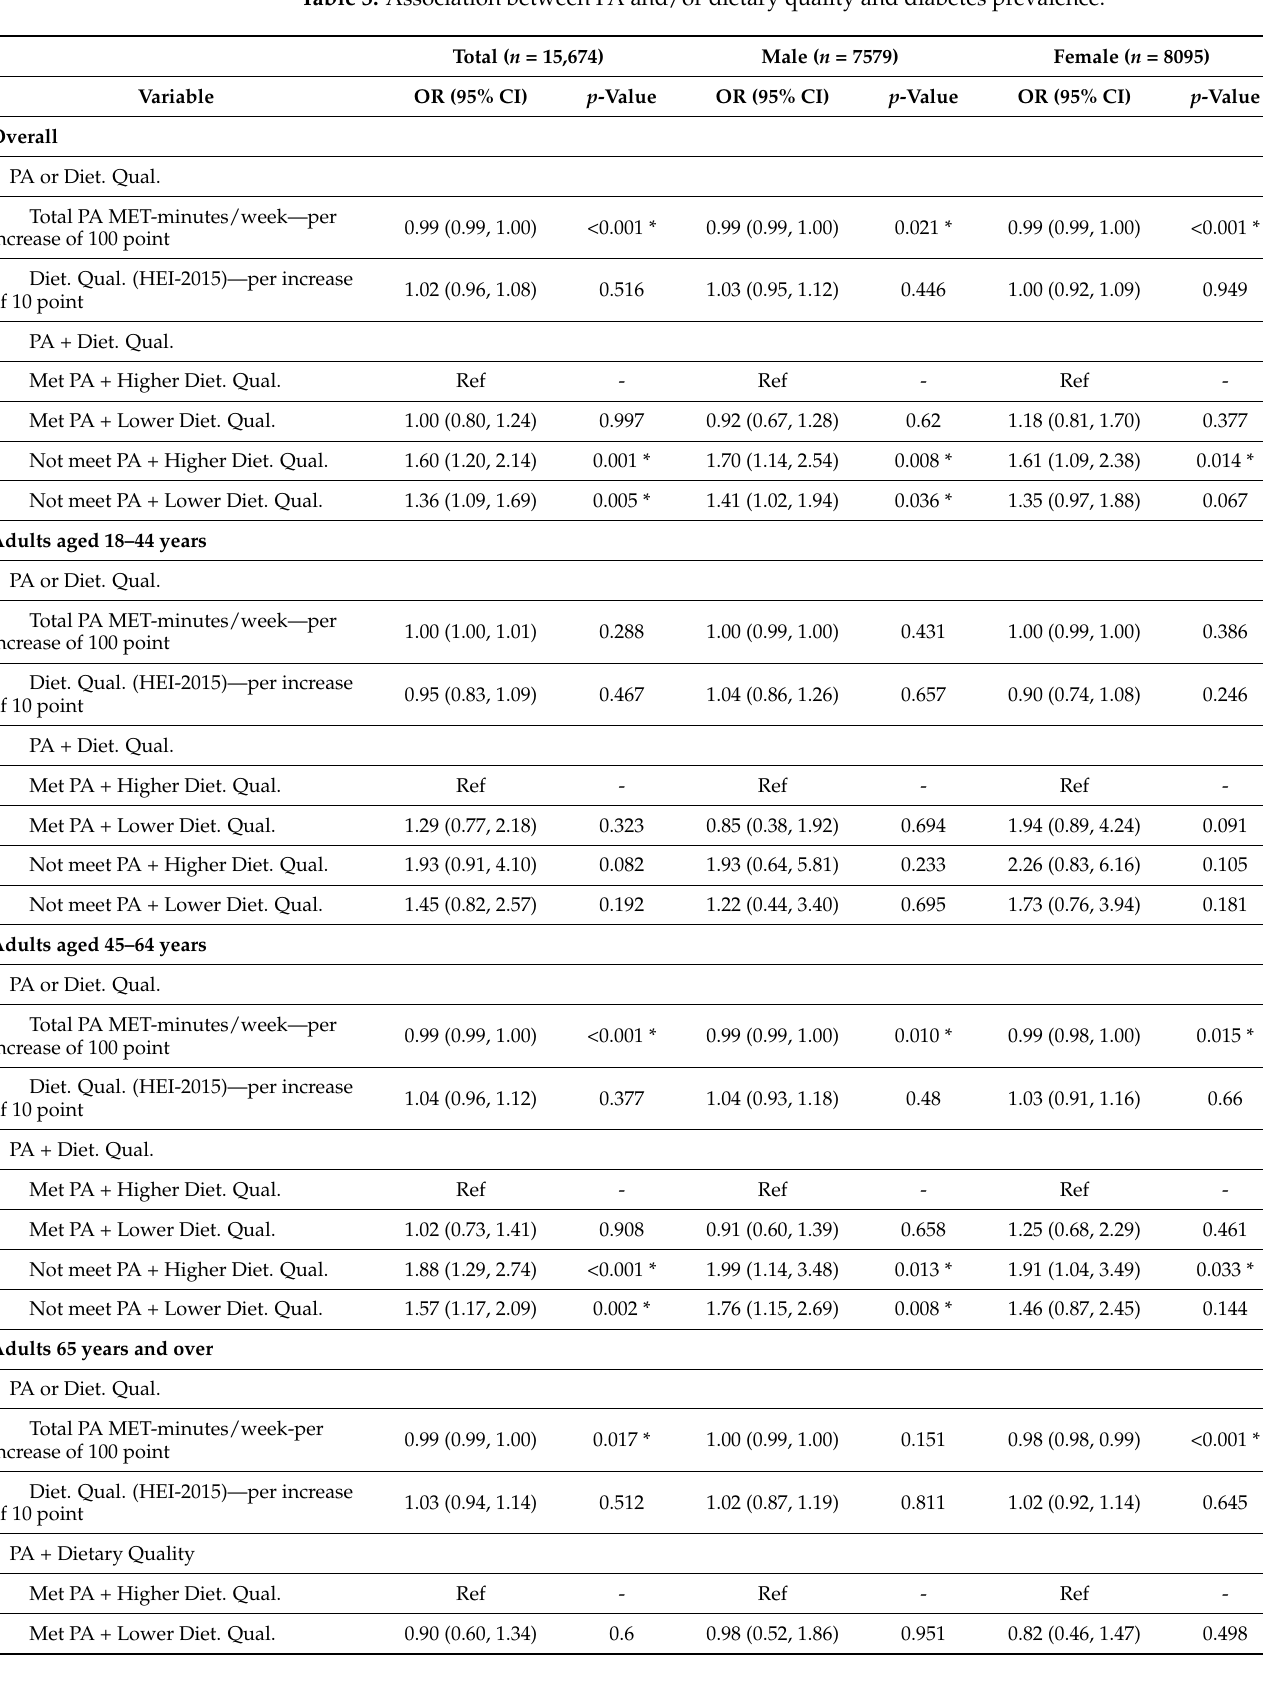
Table 3. Association between PA and/or dietary quality and diabetes